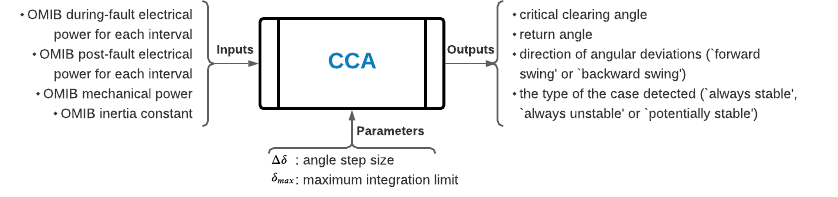
Figure 10. Schematic representation of CCA function to find the CCA of the equivalent OMIB model.